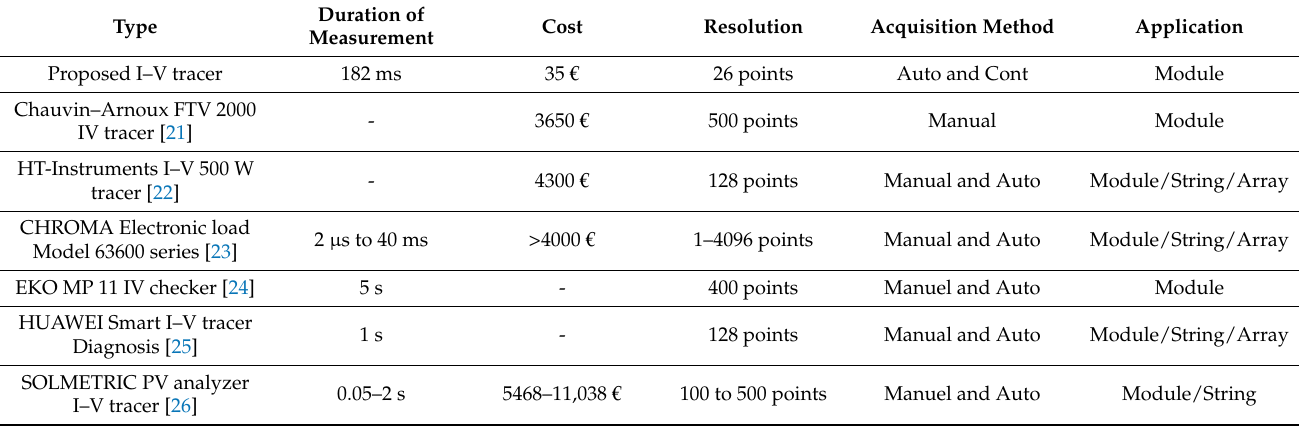
Table 2. Comparison with market I–V